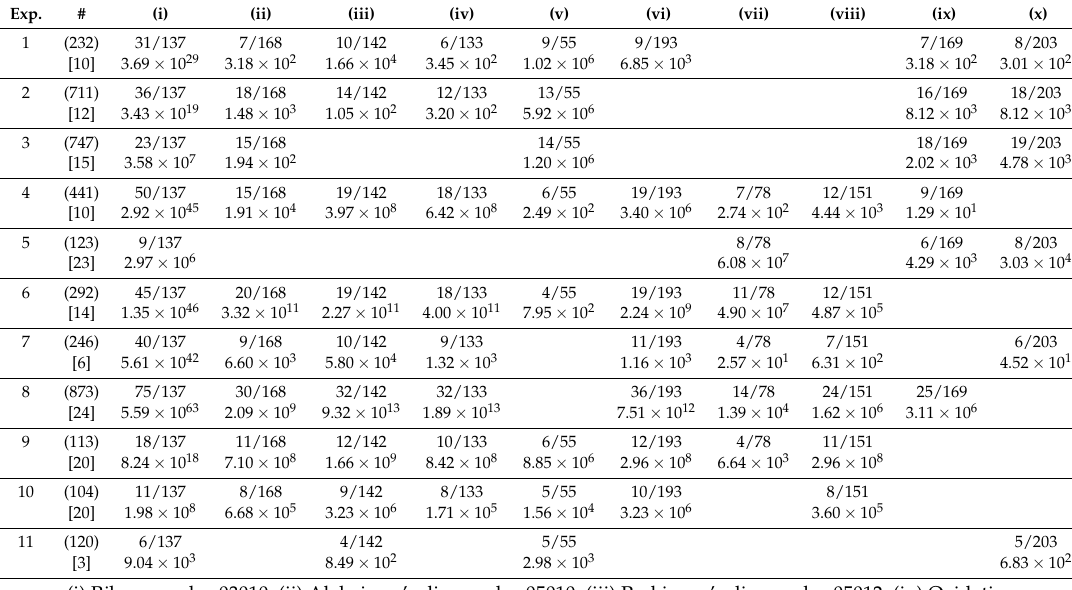
Table 4. In each of 11 experiments, 20 top-ranked significant KEGG pathways whose associated genes significantly match some genes selected for each experiment were identified. Thus, the following KEGG pathways are most frequently ranked within the top